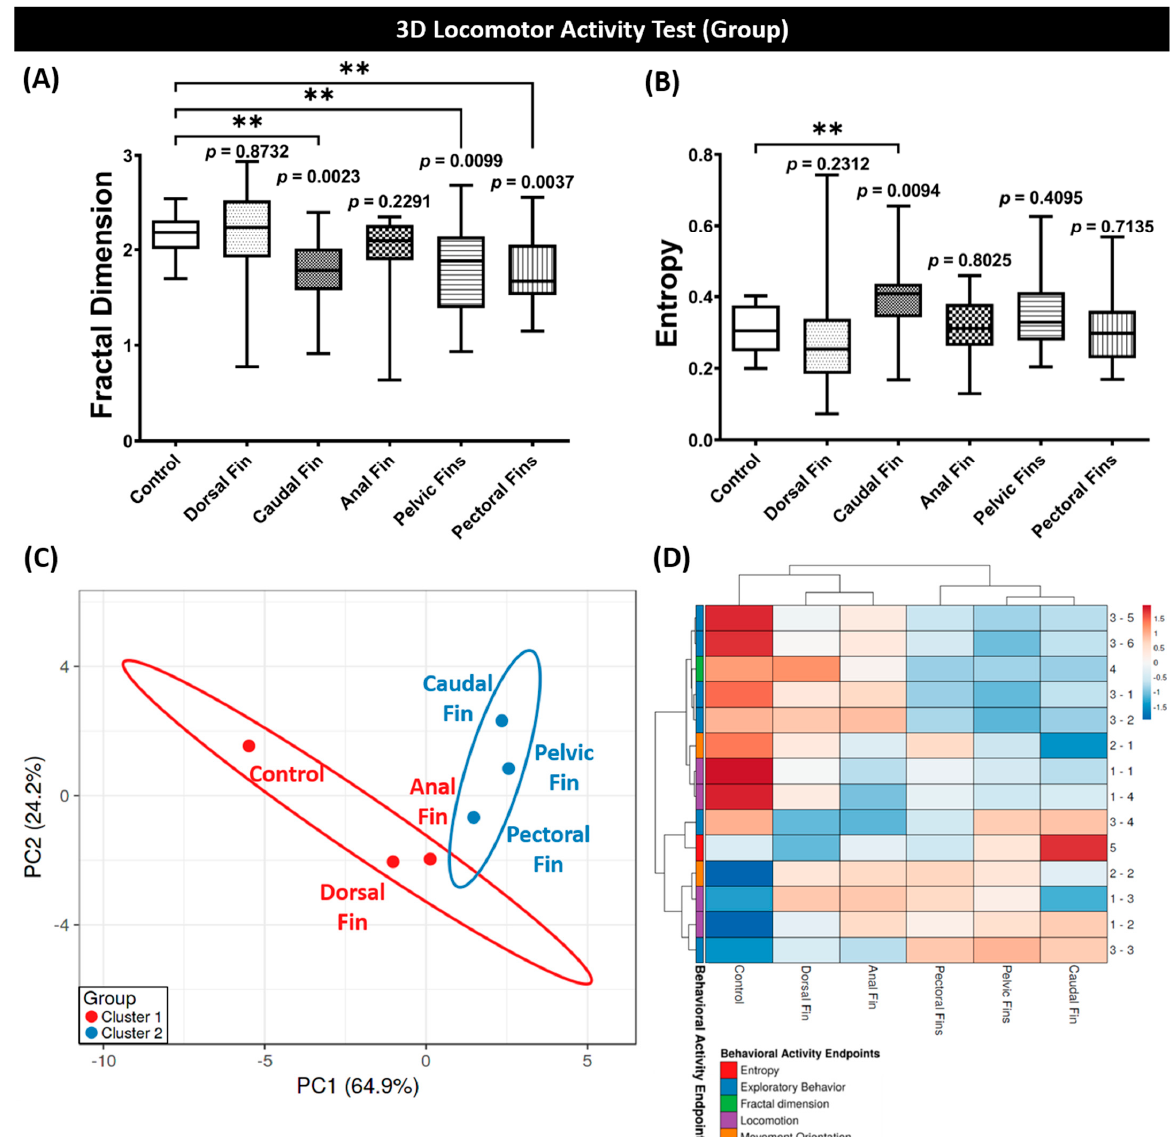
Figure 3. ( A ) Fractal dimension and ( B ) entropy analyses of grouped zebrafish (shoal size = six fishes) swimming patterns in 3D locomotion test at 2 dpa. Data are presented as box and whiskers (min to max) and were analyzed by Kruskal–Wallis test continued with uncorrected Dunn’s test ( n = 18; ** p < 0.01). ( C ) Principal component analysis (PCA) and ( D ) hierarchical clustering analysis of multiple behavior activity endpoints in zebrafish after the fin was amputated. The non-amputated group is included as the control group. In Figure 2C, two major clusters from hierarchical clustering analysis results are marked with red (cluster 1) and blue (cluster 2)